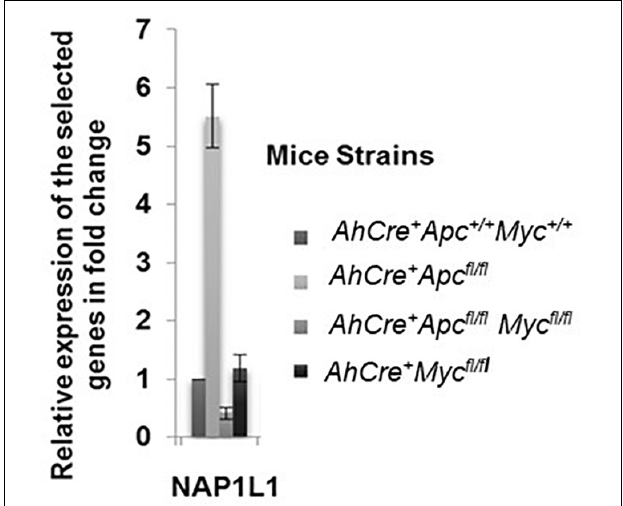
FIGURE 1 | Relative expression of Nap1l1 mRNA extracted from small intestinal epithelial samples from induced AhCre + Apc + / + Myc + / + , AhCre + Apc fl / fl , AhCre + Apc fl / fl Myc fl / fl , and AhCre + Myc fl / fl mouse models (four mice in each group) showing the fold change in mRNA expression for each gene relative to AhCre + Apc + / + Myc + / + . Error bars: standard error (SE). p < 0.05 for AhCre + Apc fl / fl compared to other groups.